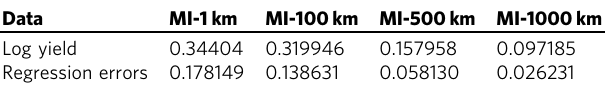
Table 1 Moran ’ s I (MI) spatial autocorrelation for log yield and regression